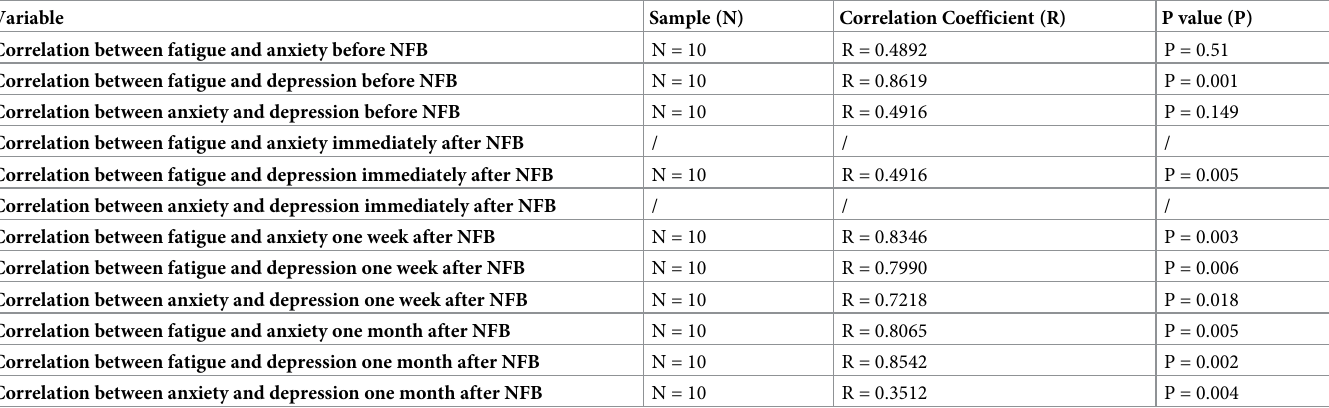
Table 4. Correlations between fatigue, anxiety and depression measured by Fatigue Assessment Scale, Beck Depression Inventory and Beck Anxiety Inventory. Variable